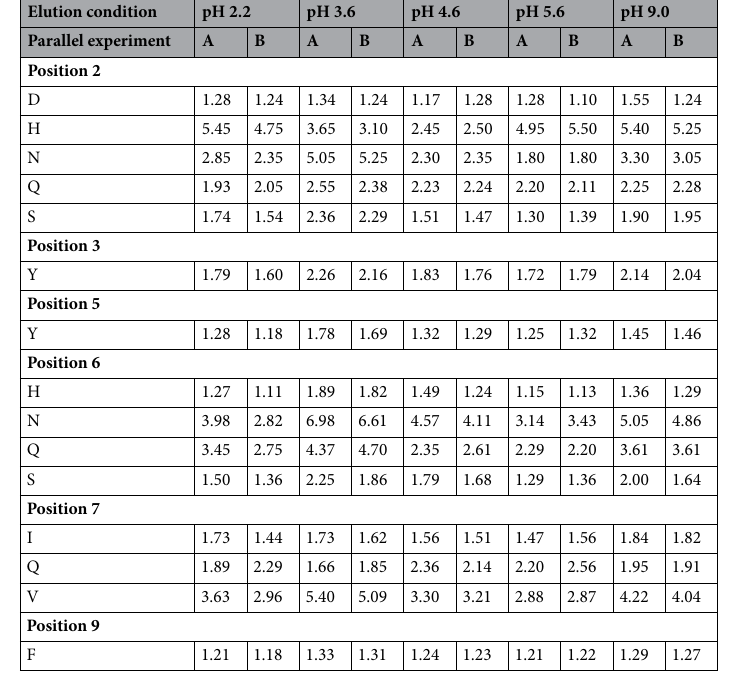
Table 1. Relative enrichment factors for amino acid residues at individual randomized positions in peptides gathered at five elution conditions. The enrichment factors were calculated relative to the frequency of same residue at cognate position in pre-screened